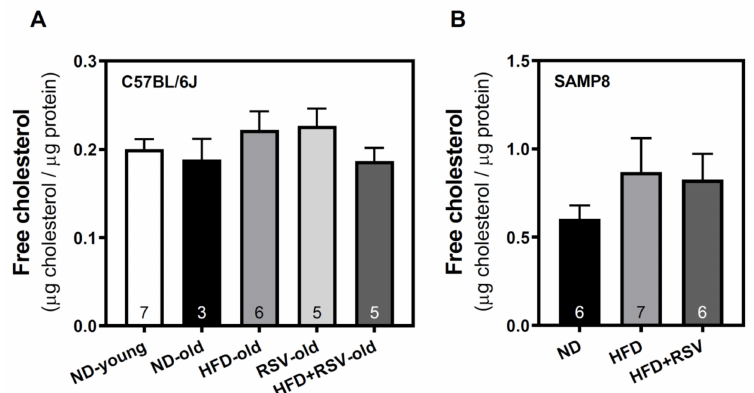
Figure 6. Level of non-esterified cholesterol in the plasma membrane of the cerebral cortex. The plasma membrane fraction was used to quantify cholesterol in the cerebral cortex from C57BL/6J ( A ) and SAMP8 ( B ) mice. Free cholesterol was measured as described in Methods. Data are the mean ± SEM of three-seven different samples (indicated within the